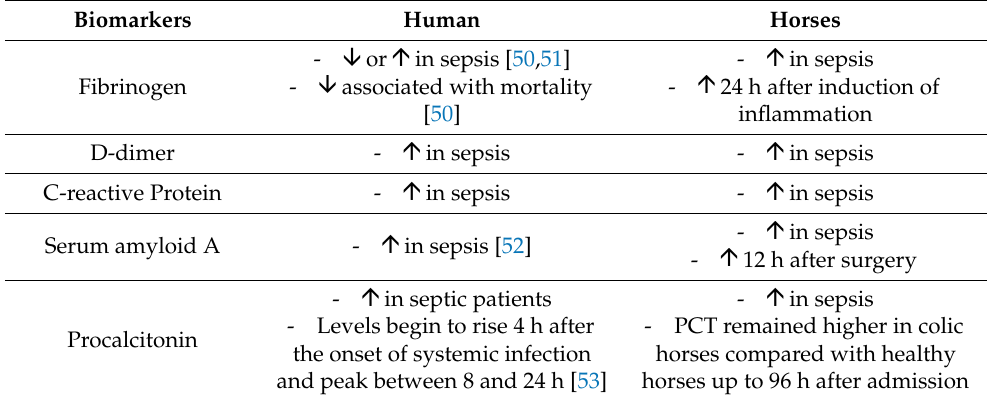
Table 6. Summary of comparison of the main biomarkers of sepsis and their changes in humans and horses.